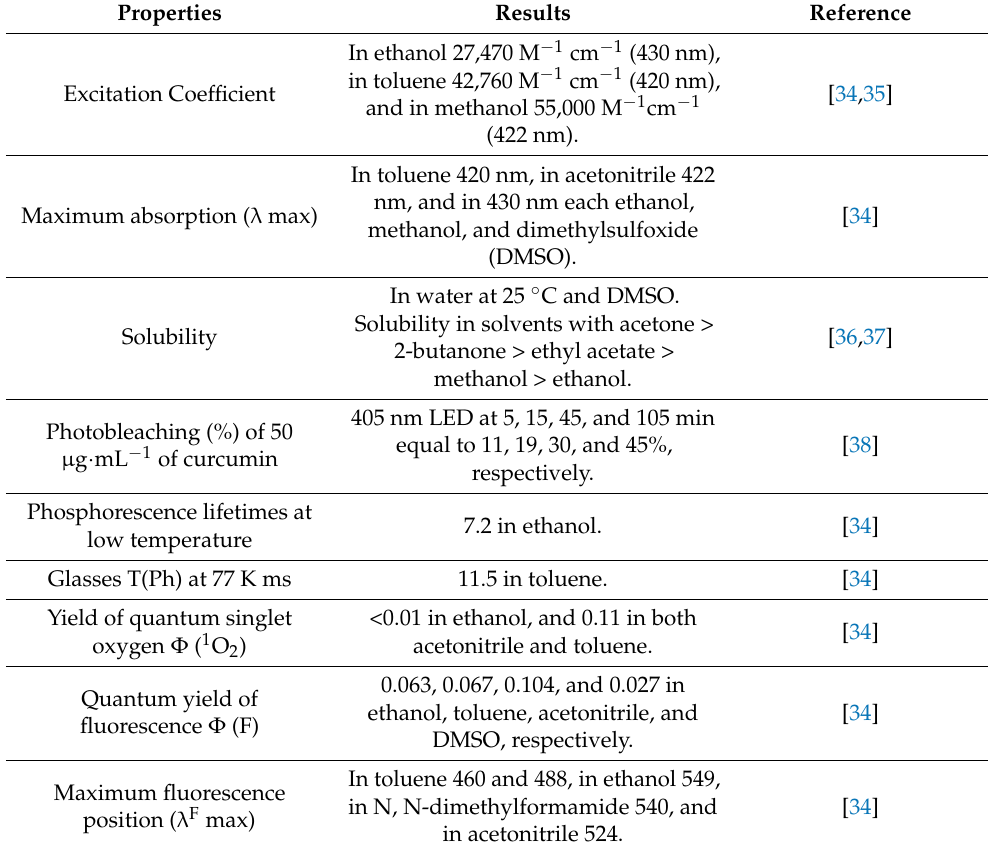
Table 1. Photophysical properties of